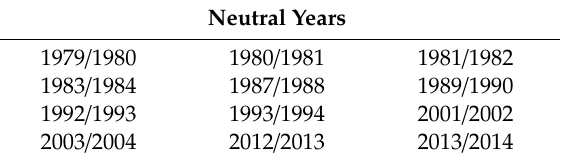
Table 3. Neutral years over the period (1979–2016) used to compute the composite maps.